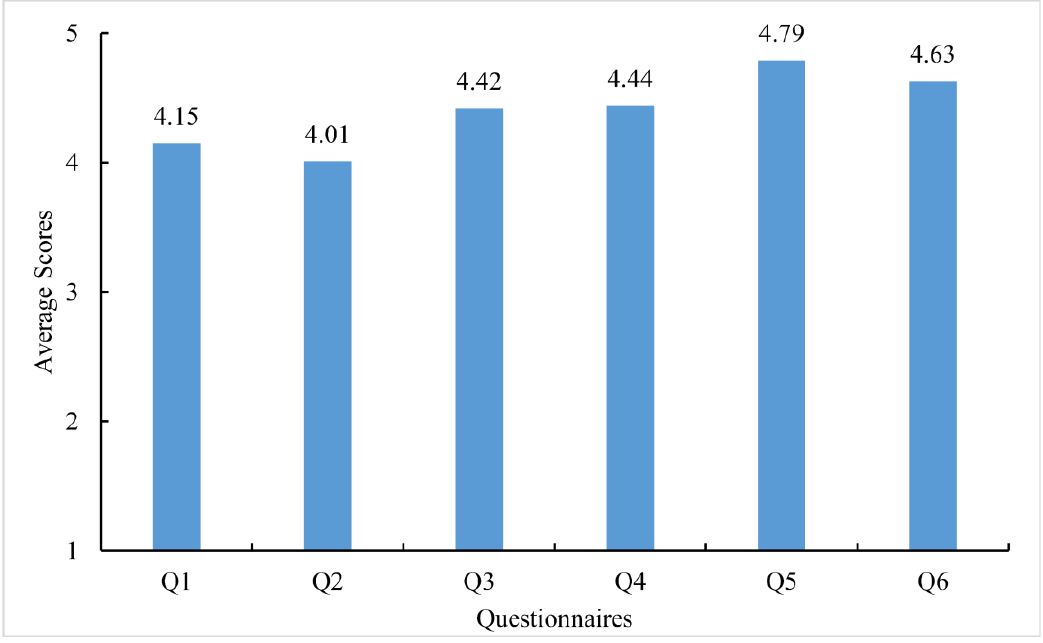
Figure 12. Average score for each question.